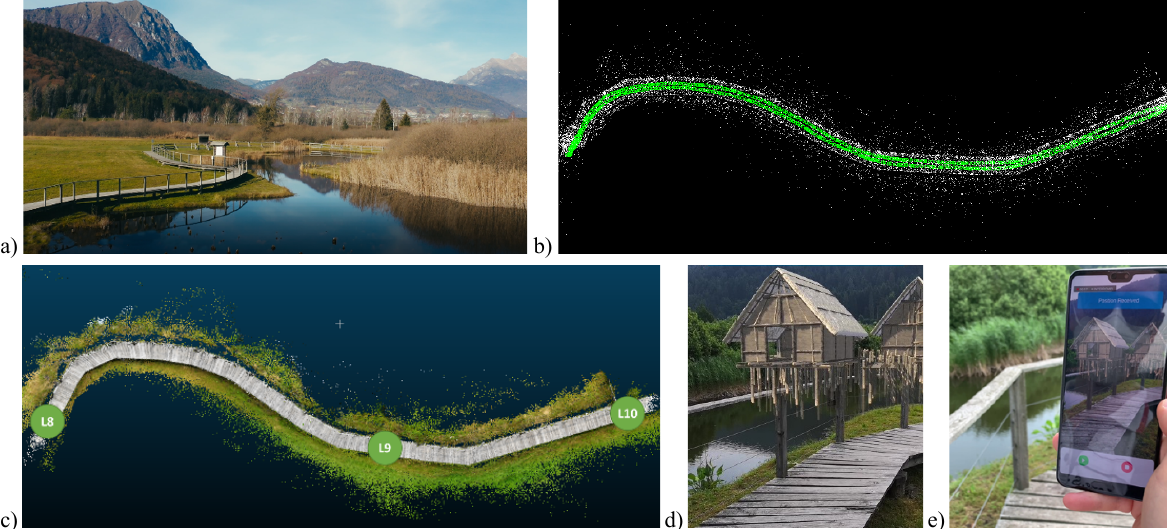
Figure 7 . The UNESCO pile dwelling of Fiavé (a). The reference sparse reconstruction of the area (b). The dense point cloud of the area and the L i positions tested for the localization (c). The reconstructive models of the pile-dwellings structures overlapped to the remaining wooden poles, visible through the AR application (d, e).